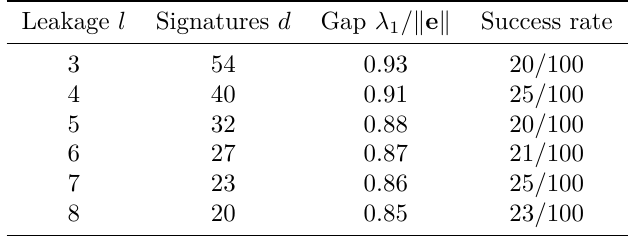
Table 3: Experimental result: gap needed to achieve ≥ 20% success rate.